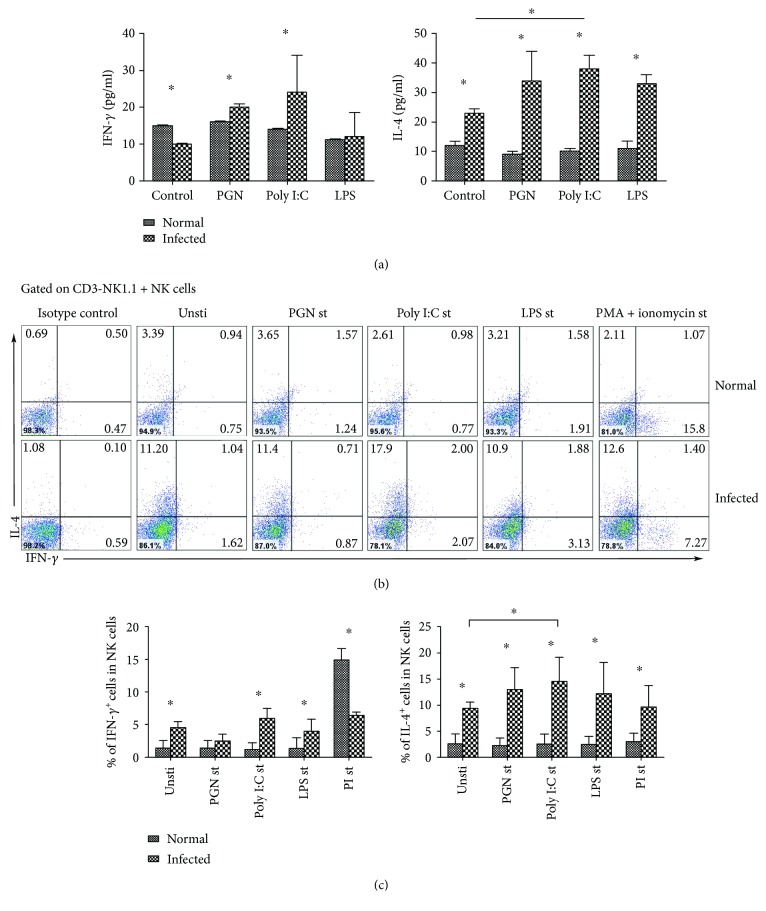
IFN-γ and IL-4 secretion induced by TLR agonists. (a) Splenic lymphocyte suspensions from normal and infected mice were prepared and cultured with PGN, Poly I:C, or LPS. Seventy-two hours later, IFN-γ or IL-4 production was assessed by using ELISA. (b) Splenic lymphocyte suspensions from normal and infected mice were prepared and stimulated with PGN, Poly I:C, LPS, or PMA plus ionomycin for 5 hours. IFN-γ and IL-4 production by splenic NK cells was assessed by using flow cytometry. Results of IFN-γ and IL-4 produced by splenic NK cells are calculated and shown (c). Data are shown as mean + SEM of 5 samples from three independent experiments. ∗P < 0.05, comparison between the normal and infected groups.